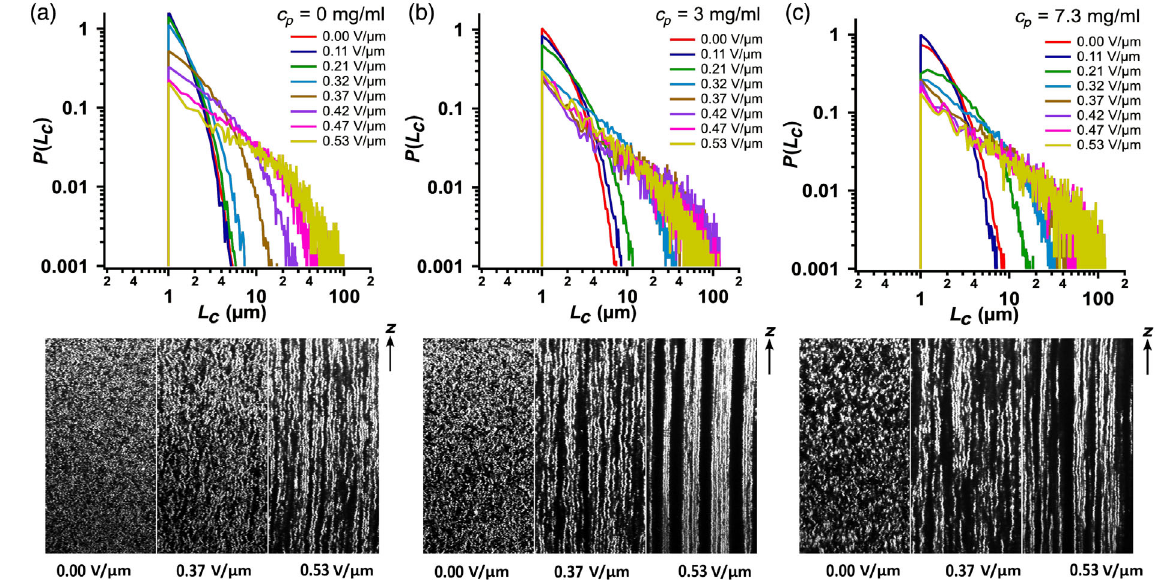
Þ ] at different field c ) increases with E and becomes a c ¼ 3 and 7 . 3 mg = ml as compared to p